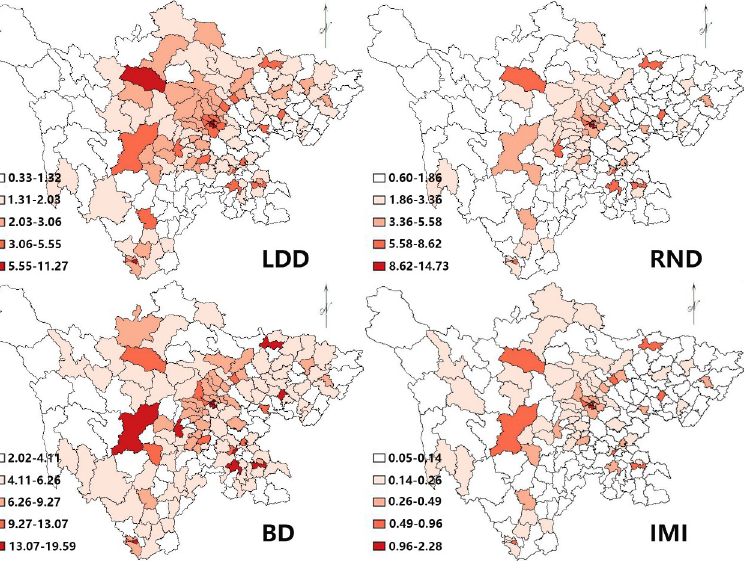
Fig 2. Hierarchical maps of densities of health resources. � The source of shape files was a public database, National Nature Resources and Geospatial basic information database of PRC (http://www.geodata.gov.cn/web/geo/index. html). Those shape files were under license without need for